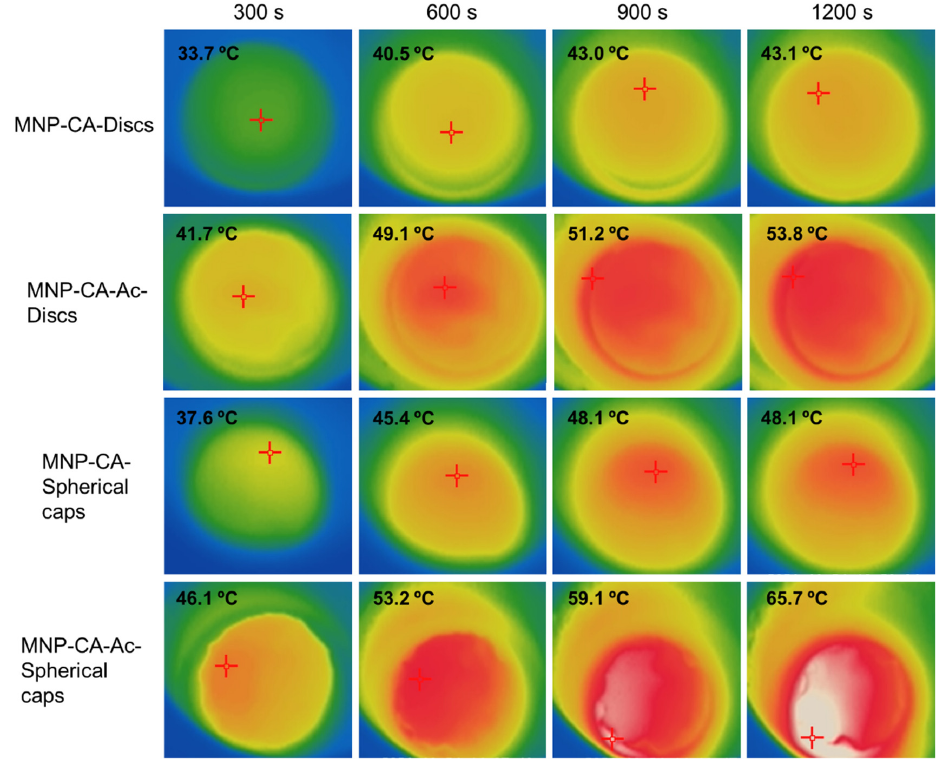
Figure 6. Thermal images indicating magnetic hyperthermia mediated temperature increase of disc shaped and spherical cap shaped gels with and without acetaminophen coating (MNP-CA and MNP-CA-Ac respectively) over time. The hyperthermia set up consisted of a copper coil and a Hikvision ds-2tp21b thermal imaging camera. The coil was heated under 19.95 V with a 14 A (AC) current at a frequency of 0.816 MHz. Gels were kept in the centre of the coil on a Teflon container and subject to heating while thermal images were taken every 10 s for 20 min. Image taken with permission from Perera et al., 2022